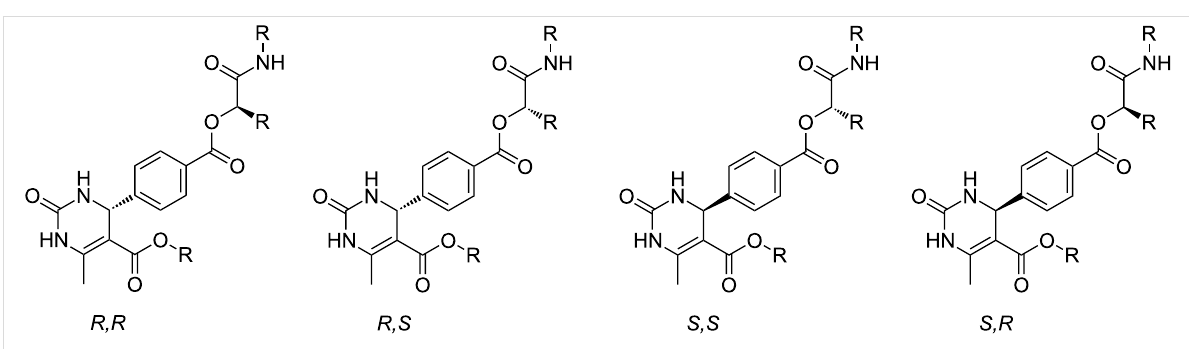
Figure 4: Stereoisomers formed in the Biginelli–Passerini tandem reaction. The homo ( RR , SS ) and hetero pairs ( RS , SR ) are